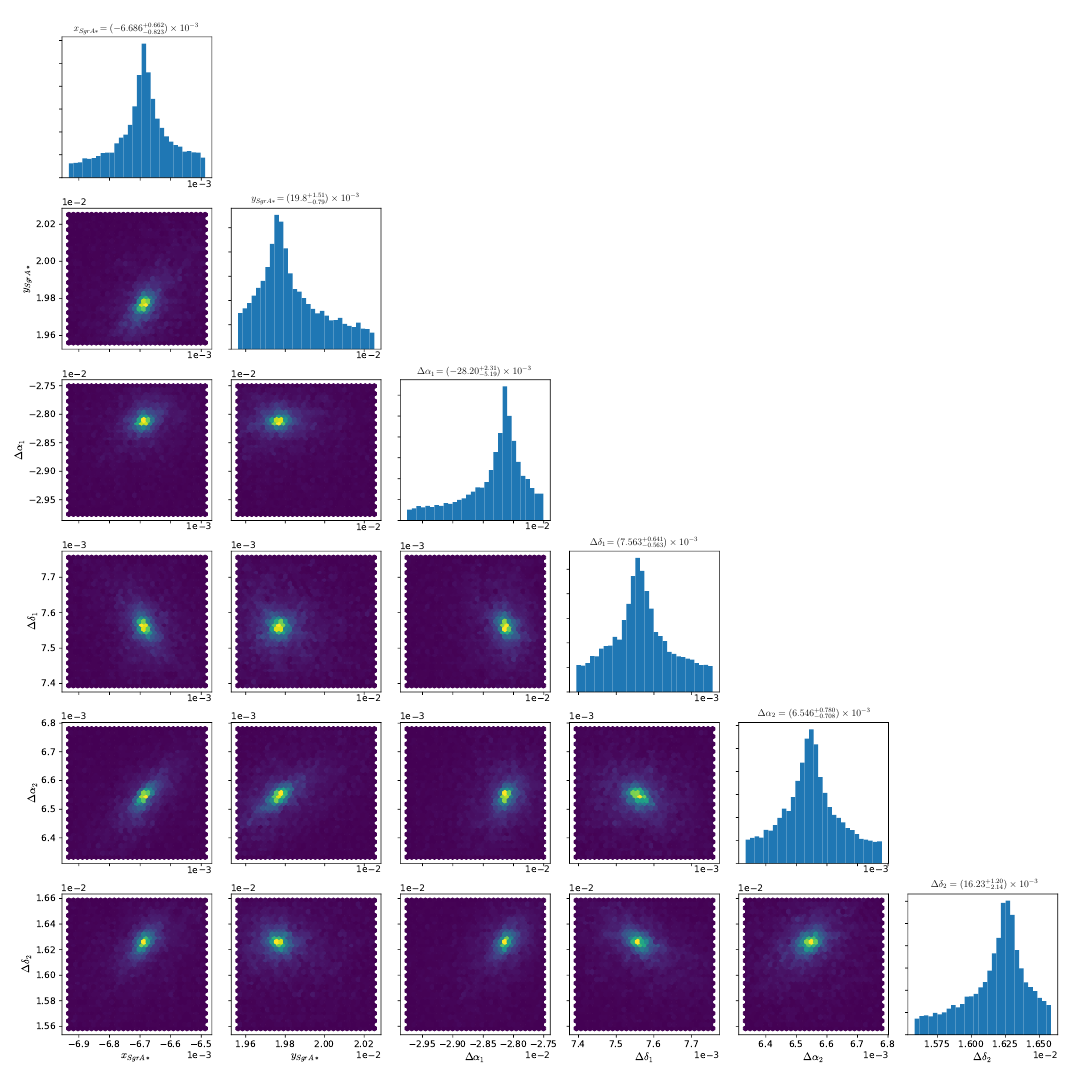
Figure A4. The posterior distribution of the position of Sgr A* and reference frames offsets. All values are given in the units of